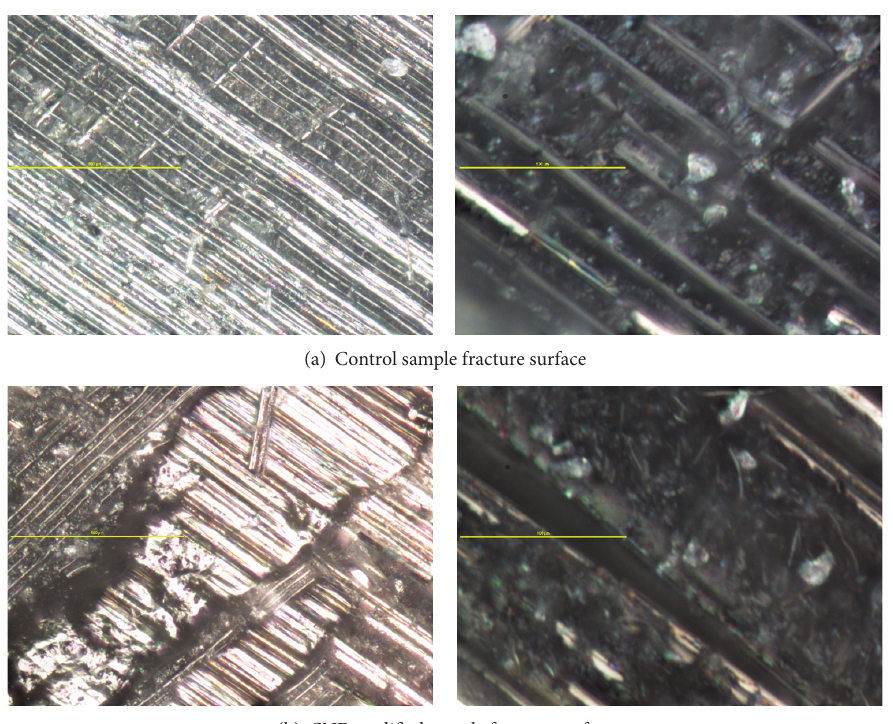
Figure 7: Surface morphology using Nikon Eclipse LV150 optical microscope. Figure 7(a) represents the control sample morphology at 400x and 2000x from left to right, respectively. Figure 7(b) represents the CNF modified sample morphology at 400x and 2000x from left to right, respectively. The scales for the 400x images measure 500 micrometers and the scales for the 2000x images measure 100